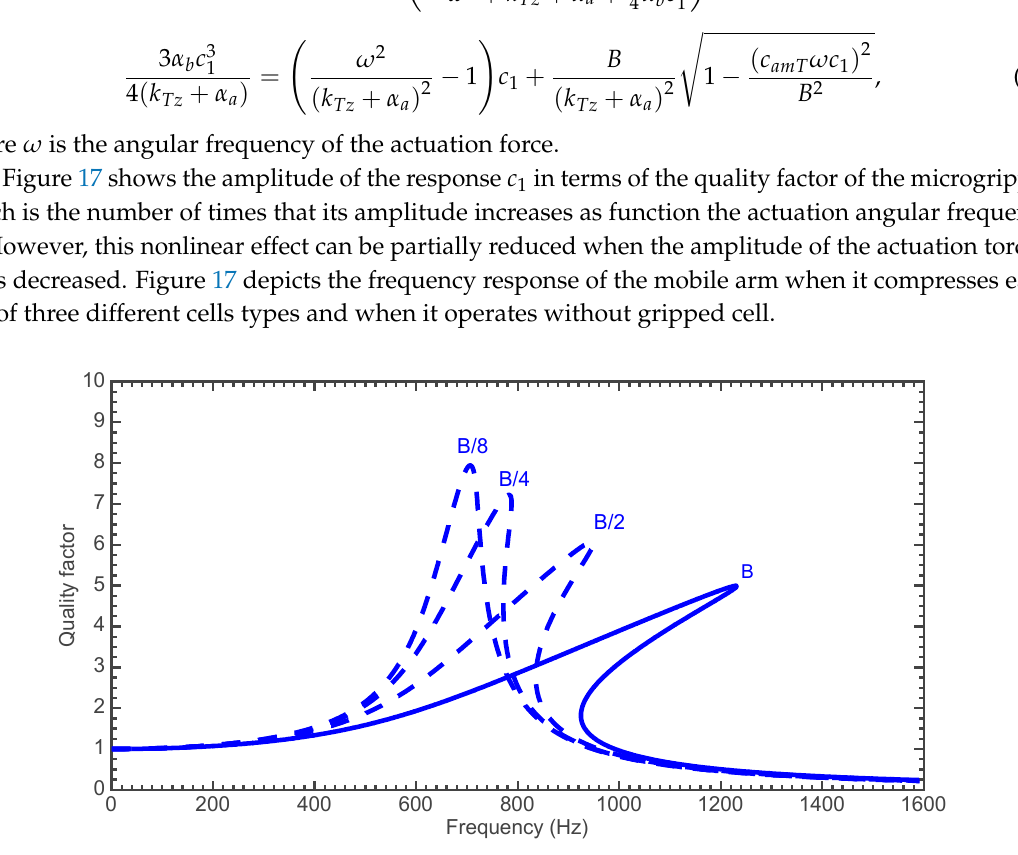
Figure 17. Frequency response of the microgripper when it squeezes a BHP cell.